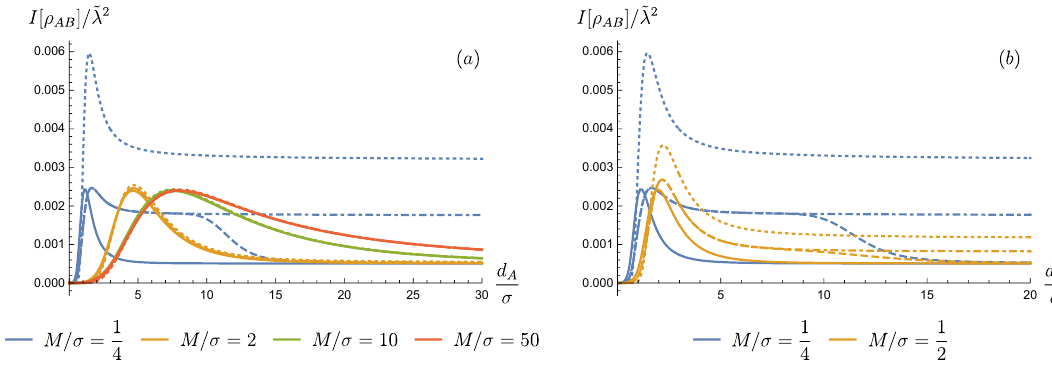
Figure 7 . Mutual information as a function of proper distance of detector A away from the horizon (in units of (cid:27) ) for various choice of vacua and for di(cid:11)erent black hole masses. In both (cid:12)gures, solid is Boulware, dotted is Hartle-Hawking-Israel, dot-dash is Unruh, and dashed is Vaidya. When the curves are indistinguishable, a solid curve is drawn. Here ~ (cid:21) = (cid:21)(cid:27) 1 (cid:0) n 2 = (cid:21) is dimensionless coupling constant. We set (cid:10) (cid:27) = 2 with detector separation d ( r A ; r B ) = 2 (cid:27) , and the detectors are turned on at (cid:28) 0 = 12 (cid:27) so that the Gaussian switching peak is very far from the shell. Note that for smaller mass black hole, the ‘bifurcation’ between Unruh and Vaidya vacuum occurs at larger